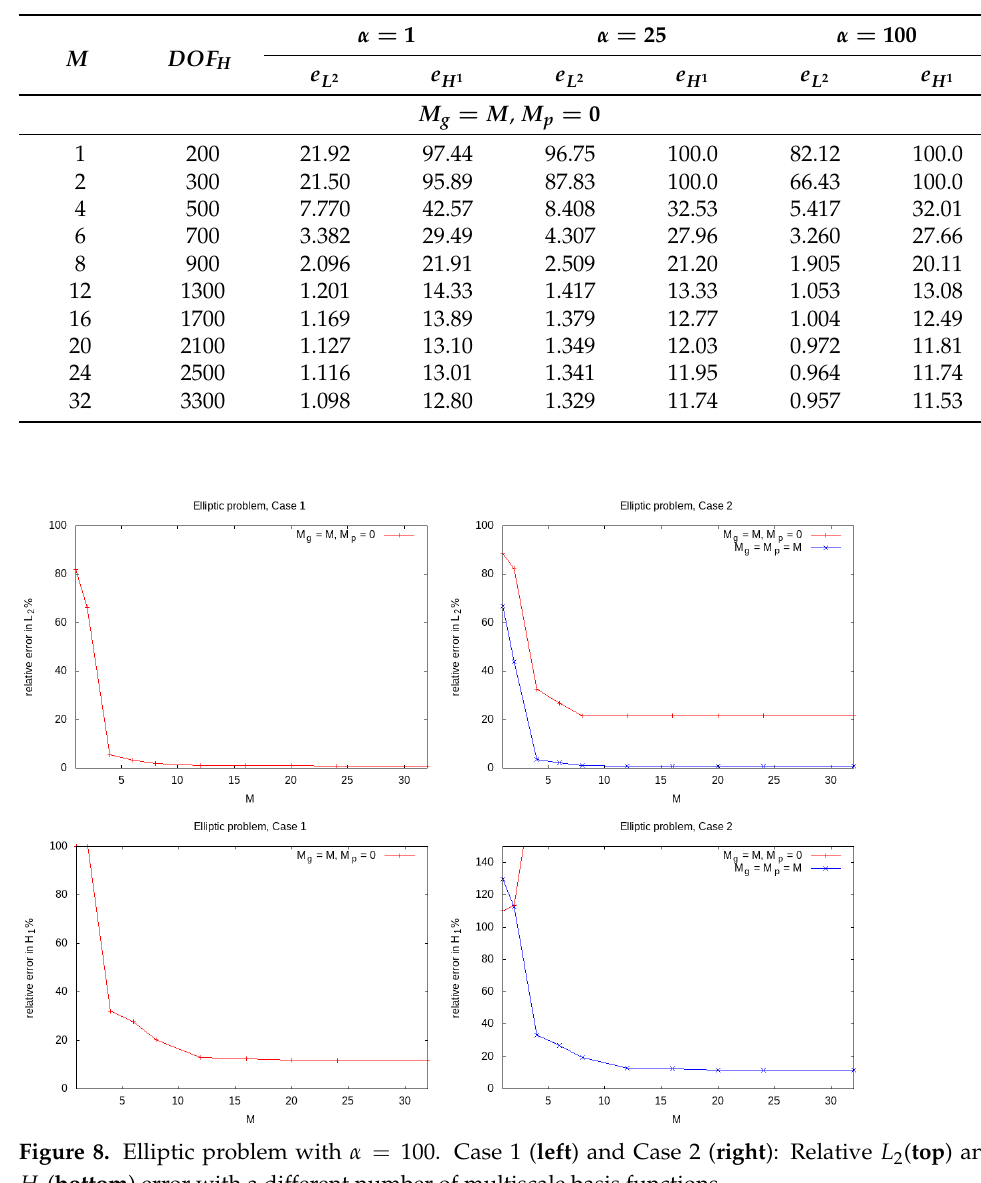
Table 1. Elliptic problem with α = 1,25, and 100. Case 1 (homogeneous boundary conditions). Relative L 2 and H 1 error in %. DOF h = 85,230.